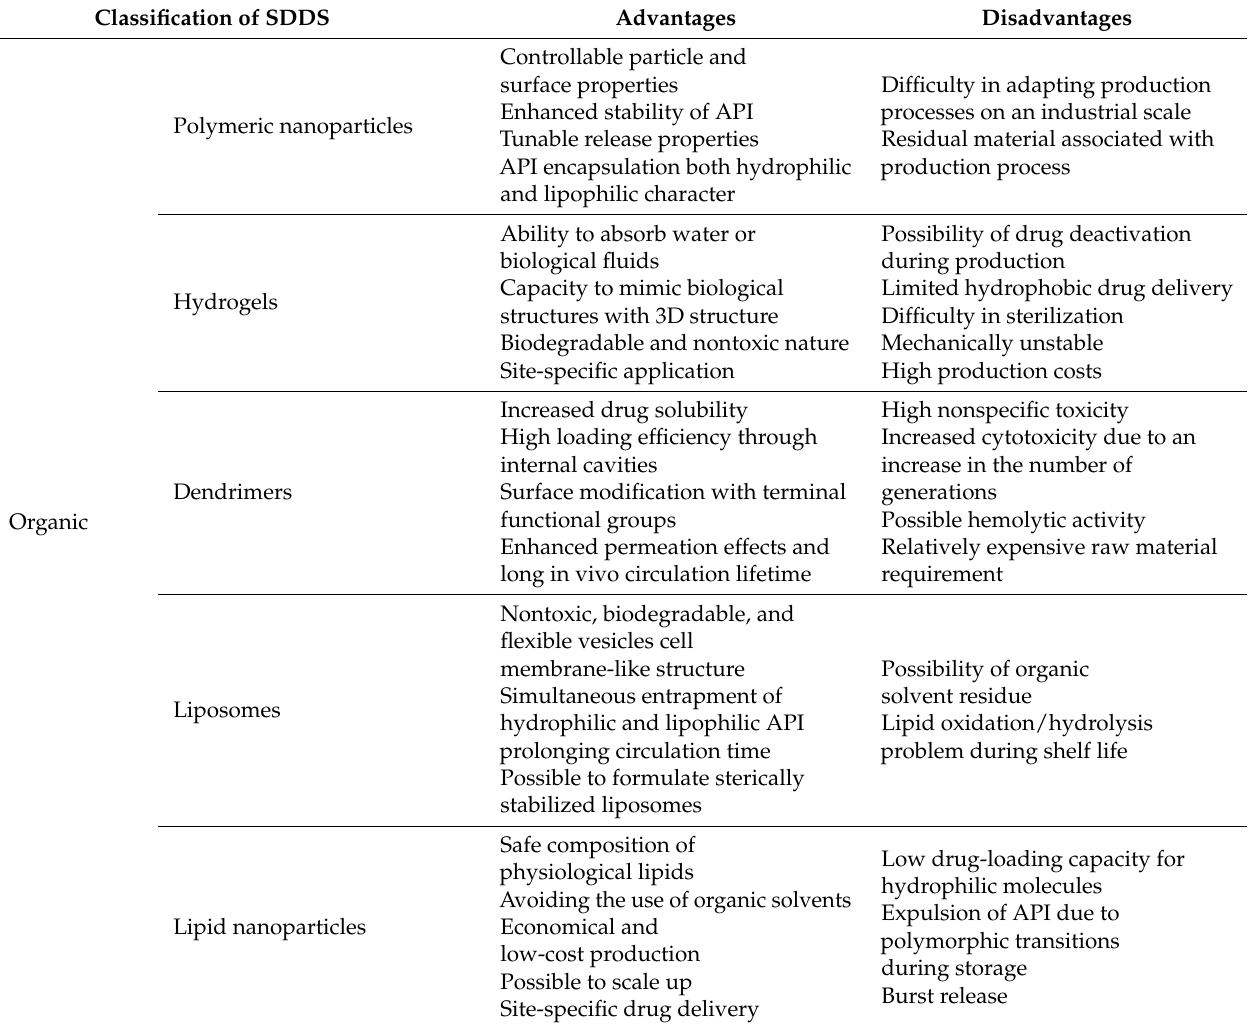
Table 1. The classification of SDDSs as well as their advantages and